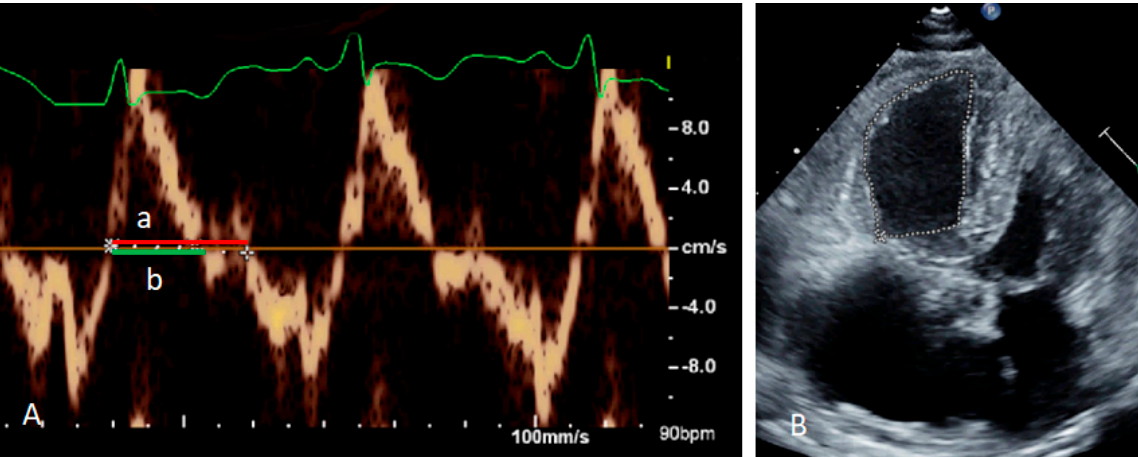
Figure 3. Right Ventricular Index of Myocardial Performance (RIMP) equals (a − b)/b, and the value was 0.64; “a” means tricuspid closure-open time, and “b” means ejection time, respectively. ( A ) The fractional area change of the right ventricle (RV FAC) on the four − chamber view was 21% ( B ).